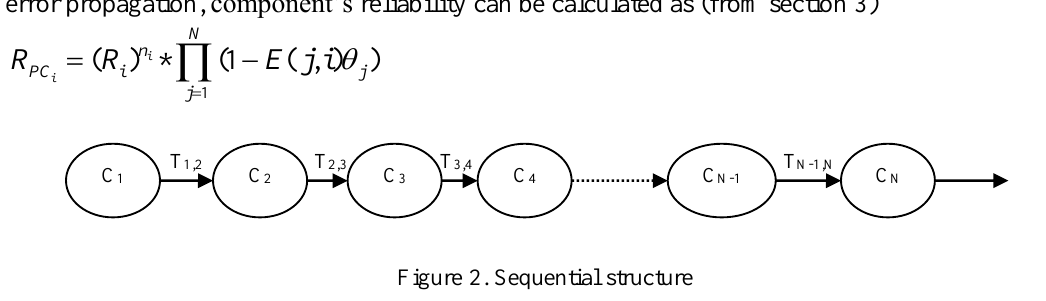
Figure 2. Sequential